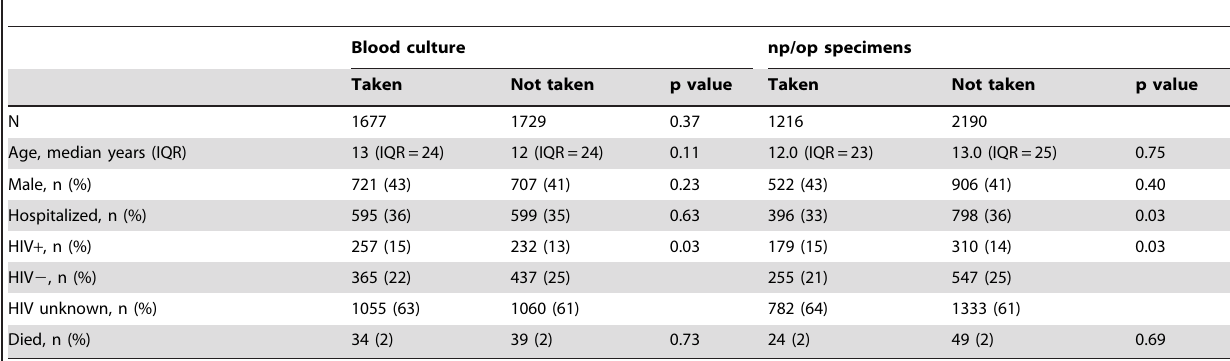
Table 1. Comparison of demographics of persons who had blood cultures and nasopharyngeal (np) and oropharyngeal (op) specimens taken and those who did not among ARI patients, western Kenya,